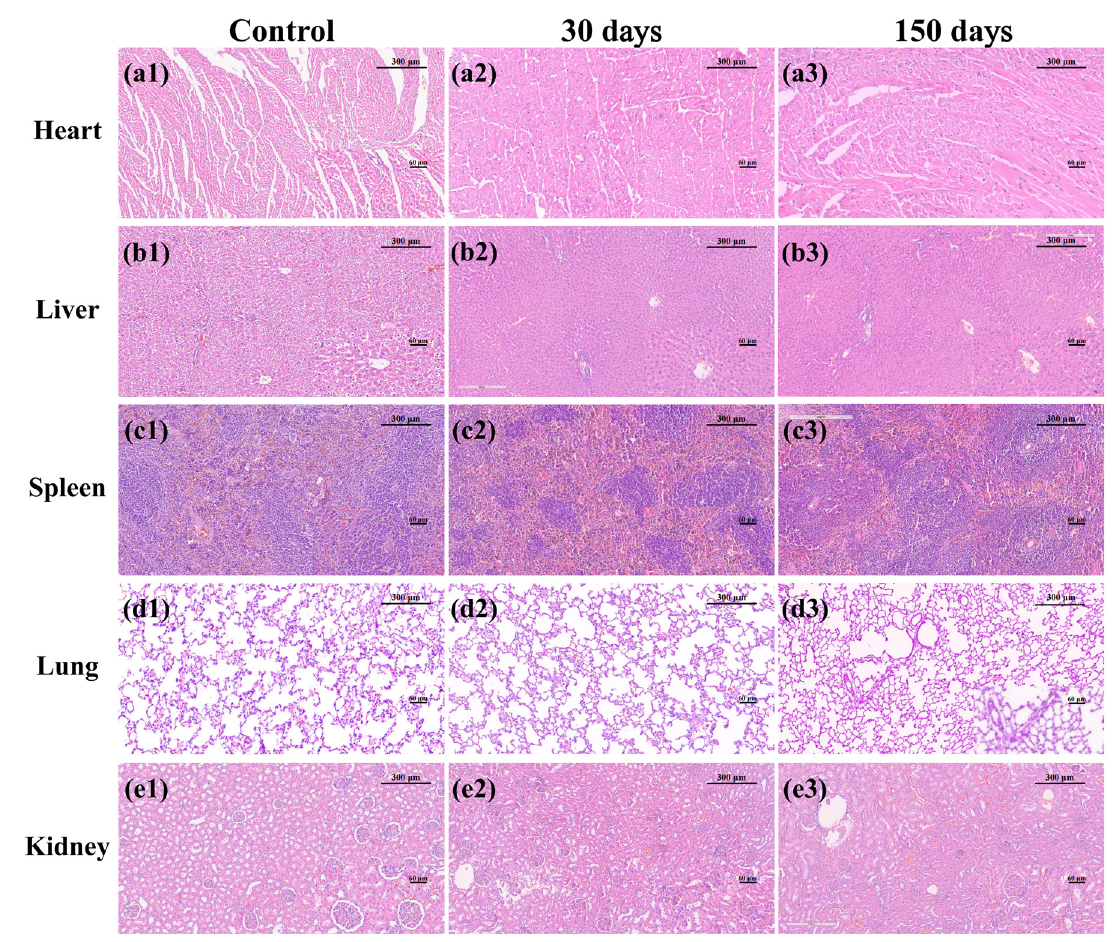
Figure 2. In vivo systemic toxicity associated with three biomaterials. ( a1 – a3 ) H&E staining of the hearts in the control, 30-day and 150-day groups. ( b1 – b3 ) H&E staining of the livers in the control, 30-day and 150-day groups. ( c1 – c3 ) H&E staining of the spleens in the control, 30-day and 150-day groups. ( d1 – d3 ) H&E staining of the lungs in the control, 30-day and 150-day groups. ( e1 – e3 ) H&E staining of the kidneys in the control, 30-day and 150-day groups. No significant inflammatory in- filtration or tissue necrosis was observed. p ˃ 0.05 versus the normal group. (100×, bar, 300 μ m; insets show tissue details at 400×, bar, 60 μ